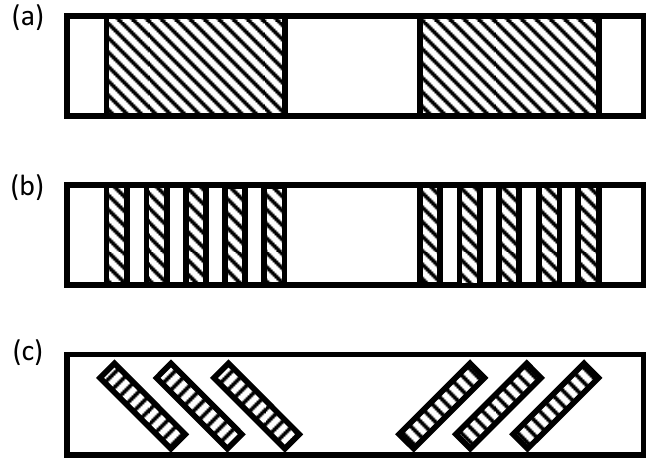
Figure 14. Different strengthening schemes: ( a ) Continuous wraps ( b ) discontinuous vertical strips ( c ) discontinuous inclined strips.